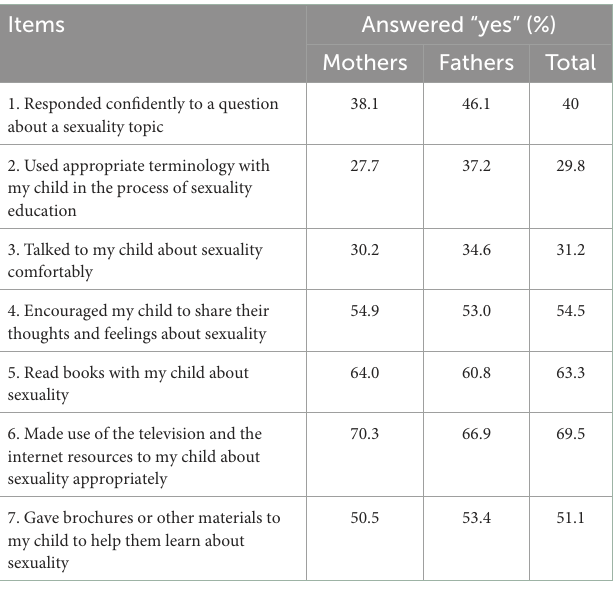
TABLE 2 Parental knowledge of children sexuality education ( N = 19,745).